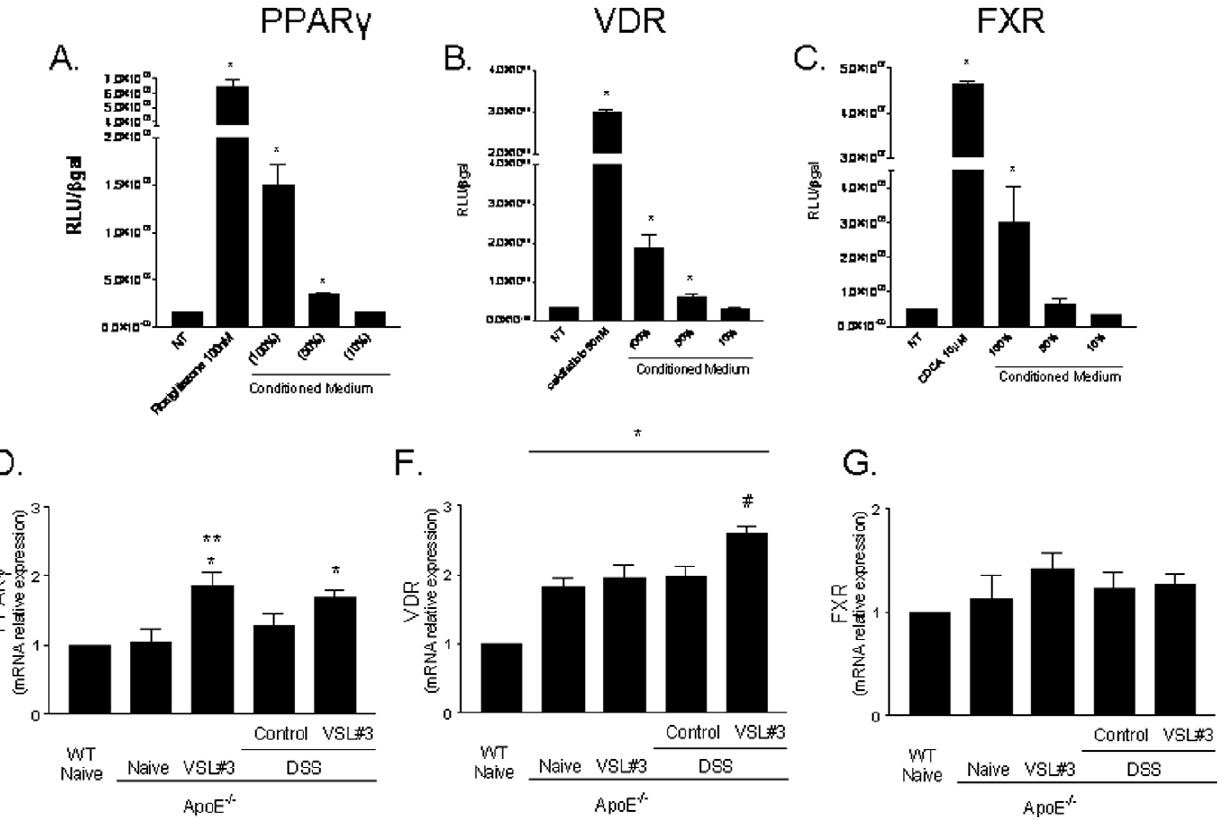
Figure 7. Effect of VSL # 3 administration on PPARy, VDR and FXR, activity and expression. A ) Luciferase reporter assay performed in HepG2 transiently transfected with p(UAS)5-TKLUC, pSG5GAL4-PPAR c and pCMV- b gal vectors and stimulated 18 h with rosiglitazone 100 nM and condiditioned media (CM) undiluted, diluted 1:2 (50%) and 1:10 (10%). *p , 0.05 versus not treated (NT); B ) Luciferase reporter assay performed in HepG2 transiently transfected with p(UAS)5-TKLUC, pSG5GAL4-VDR and pCMV- b gal vectors and stimulated 18 h with 25-hydroxycholecalciferol, 50 nM, and CM undiluted, diluted 1:2 (50%) or 1:10 (10%). *p , 0.05 versus not treated (NT); C ) Luciferase reporter assay performed in HepG2 transiently transfected with p(hsp27)TKLUC, pSG5-FXR, pSG5-RXR, pCMV- b gal vectors and stimulated 18 h with CDCA 10 m M and CM undiluted, diluted 1:2 (50%) and diluted 1:10 (10%). *p , 0.05 versus not treated (NT). ( Panel D–G ) RT-PCR analysis of the intestinal expression of PPAR c , VDR and FXR. Data represent the mean 6 SE of 5 mice per group. * p , 0.05 ApoE 2 / 2 experimental group versus naive wild type group; ** p , 0.05 ApoE 2 / 2 naı¨ve group versus ApoE 2 / 2 plus VSL # 3 group; $ p , 0.05 ApoE 2 / 2 naive group versus ApoE 2 / 2 plus DSS group; # p , 0.05 ApoE 2 / 2 plus DSS group versus ApoE 2 / 2 plus DSS and VSL # 3